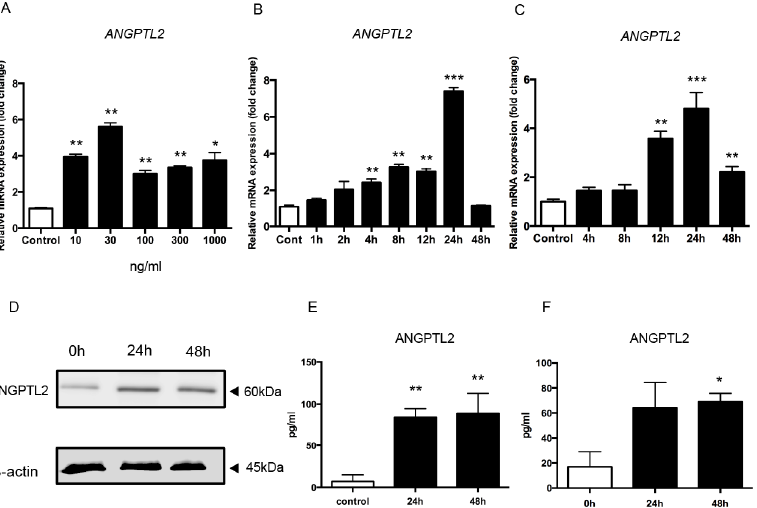
Fig 2. ANGPTL2 is upregulated by P . gingivalis LPS in Ca9-22 cells and HGECs. ANGPTL2 is upregulatedby P . gingivalis LPS in Ca9-22cells and HGECs. (A, B) ANGPTL2 mRNA expressionwas measuredin primed Ca9-22cells stimulatedwith (A) 0, 10, 30, 100, 300, or 1000 ng/ml P . gingivalis LPS for 24 h or (B) 30 ng/ml P . gingivalis LPS for 0–48 h. (C) ANGPTL2 mRNA expressionwas measuredin primed HGECs stimulated with 30 ng/ml P . gingivalis LPS for 0–48h. Differencesamonggroups were analyzedusing one-wayANOVA. Data are expressedas means ± SD ( n = 3). * p < 0.05, ** p < 0.01, *** p < 0.001 vs. control. (D) Western blot showingANGPTL2 (60 kDa) levels after stimulation with 30 ng/ml P . gingivalis LPS for 24 and 48 h. (E) ANGPTL2 protein levels in Ca9-22cells culture supernatantafter 24 and 48 h stimulationwith 30 ng/ml P . gingivalis LPS. (F) ANGPTL2 protein levels in HGEC culture supernatants at 24 and 48 h after stimulationwith 30 ng/ml P . gingivalis LPS. Differences among groupswere analyzedusing one-way ANOVA. Data are expressedas means ± SD (n = 4). * p < 0.05, ** p < 0.01 vs. control.